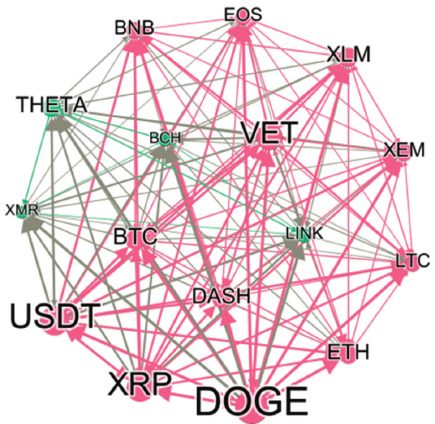
Figure 39: Risk spillover under R3.